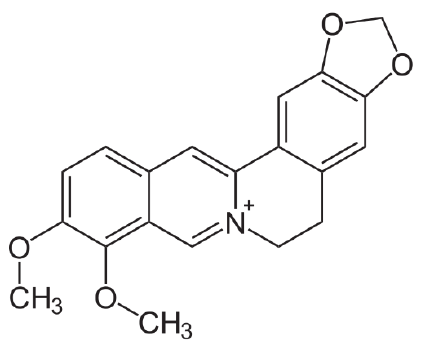
Figure 1. Chemical structure of berberine.